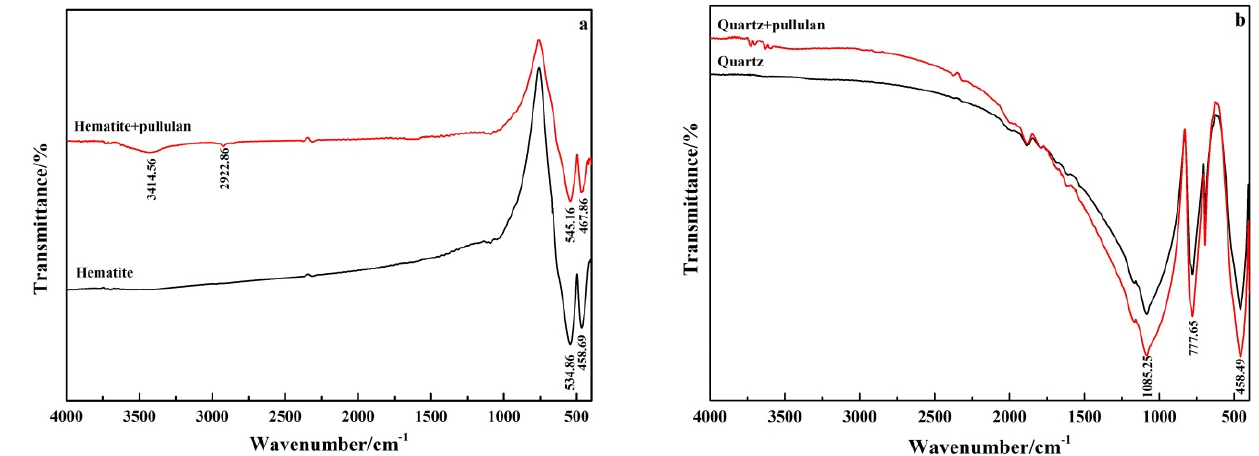
Figure 9. FT − IR spectra of hematite ( a ) and quartz ( b ) before and after pullulan treatment. As shown in Figure 8b, the characteristic peaks of quartz were located at 458.49 cm − 1 , 777.65 cm − 1 and 1085.25 cm − 1 . No new absorption peak appeared on the quartz surface treated by pullulan, and the original characteristic peak did not shift. This indicated that there was no chemisorption between quartz and pullulan. These results were consis- tent with zeta potential test results, which further indicated that pullulan could adsorb